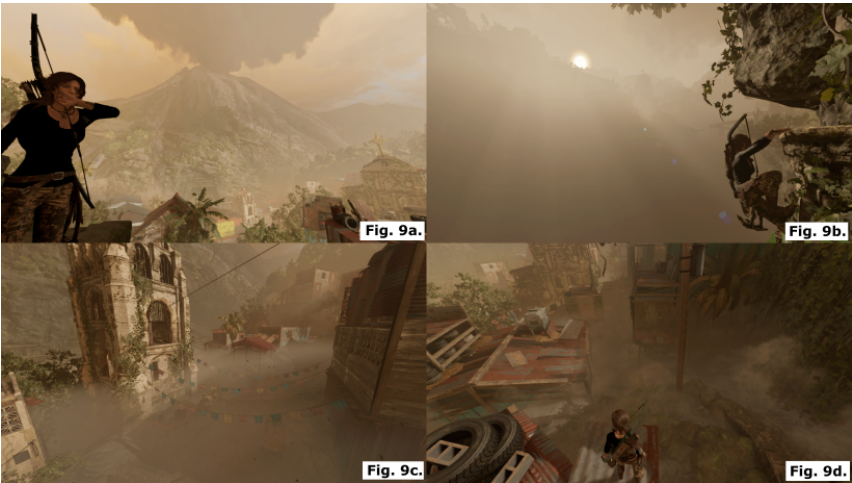
Figure 9. Tephra and volcanic haze visual effects in The Shadow of the Tomb Raider © Eidos-Montréal